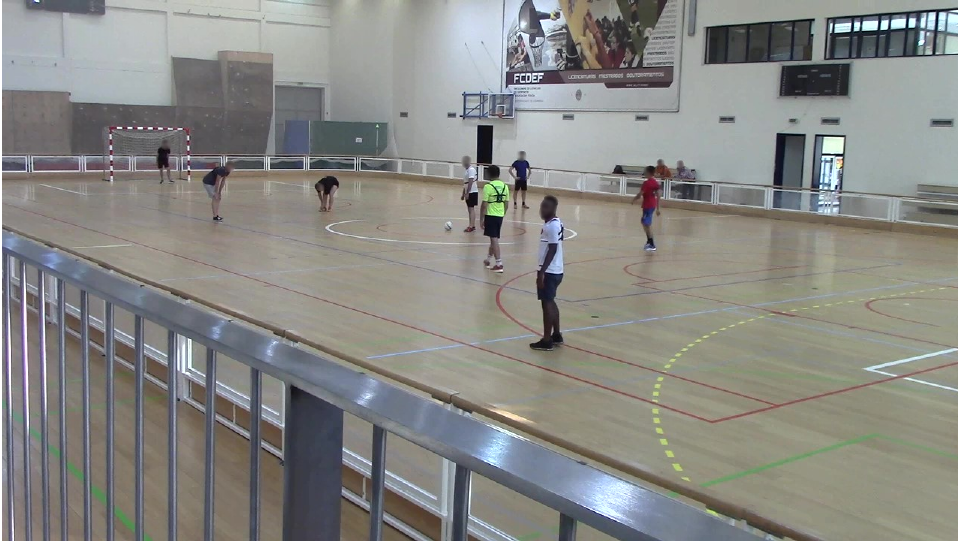
Figure 2. A game frame acquired by the video camera.